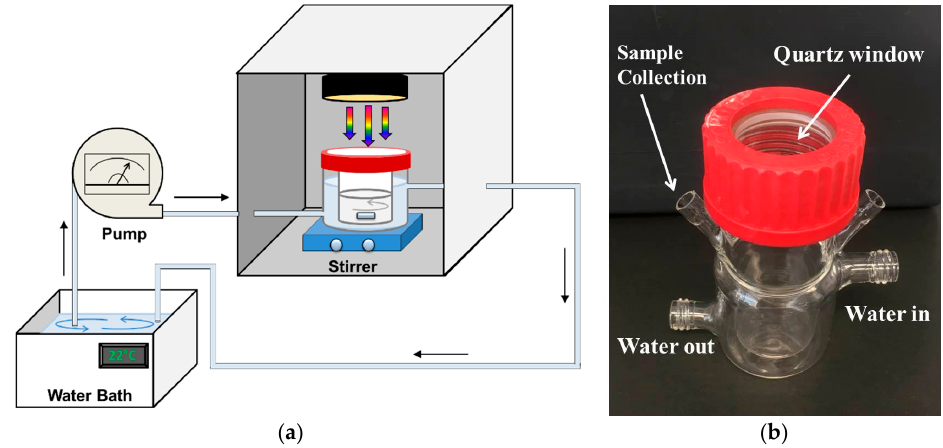
Figure 1. ( a ) Schematic of the set-up for photocatalytic tests; and ( b ) photocatalytic cell.